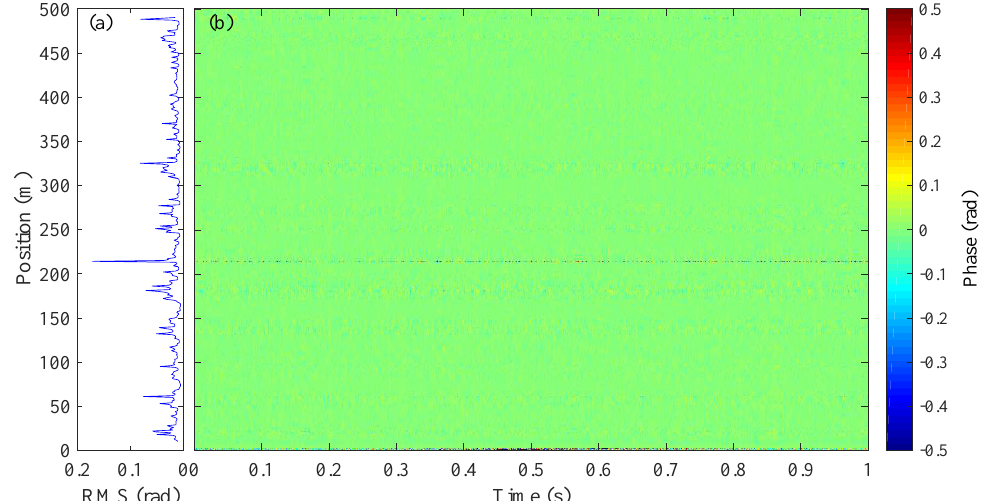
Figure 9. ( a ) RMS and ( b ) waterfall plot of the demodulated phase over position with WCSA applied.